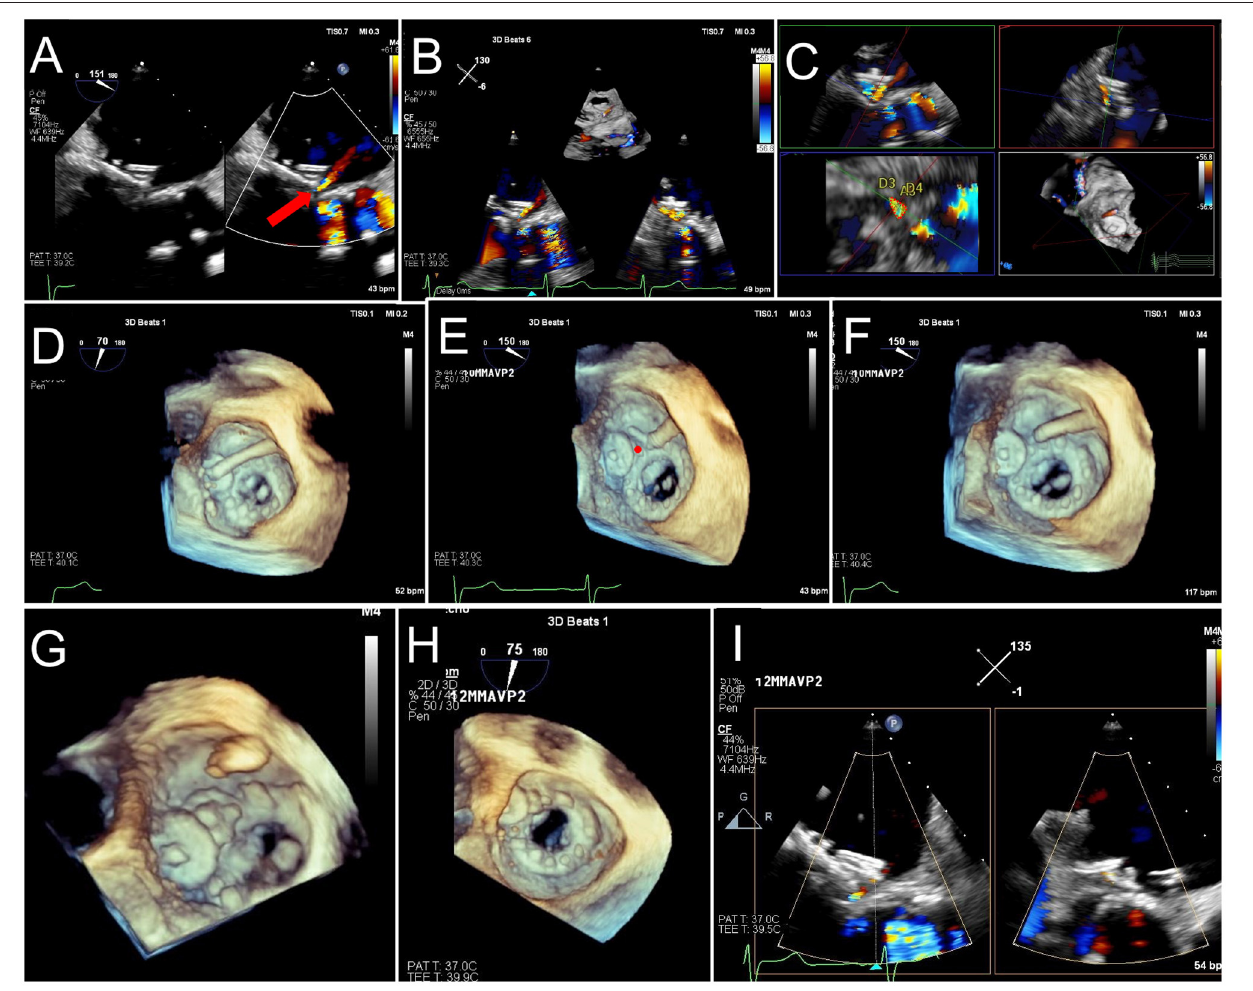
FIGURE 12 | TEE Guided Implantation of a Second PVL Closure Device for Residual Leak. (A) After an initial deployment of a 10mm AVPII device, a residual leak is seen adjacent to the first device (red arrow). (B) A sector-based 3D Color Doppler acquisition demonstrates the location of the residual leak medial to the first device. (C) Multiplanar reconstruction of the 3D color Doppler acquisition is aligned with the jet for measurement of the paravalvular defect (lower left panel, dotted red tracing), measuring 17 mm 2 , with dimensions 10 x 4mm. (D) The guide catheter is positioned on top of the first device, too lateral to enter the defect. (E) The guide is pulled back, and wire crossing of the defect (red circle) is attempted. Wire trajectory is medial and anterior to the defect. (F) After correction of wire trajectory, the defect is crossed. (G) A 12mm AVPII device is deployed within the residual defect. (H) Bioprosthetic leaflet opening appears normal, without interference from the closure devices. (I) Biplane color Doppler imaging demonstrates trivial residual leak after deployment of the 2nd PVL closure